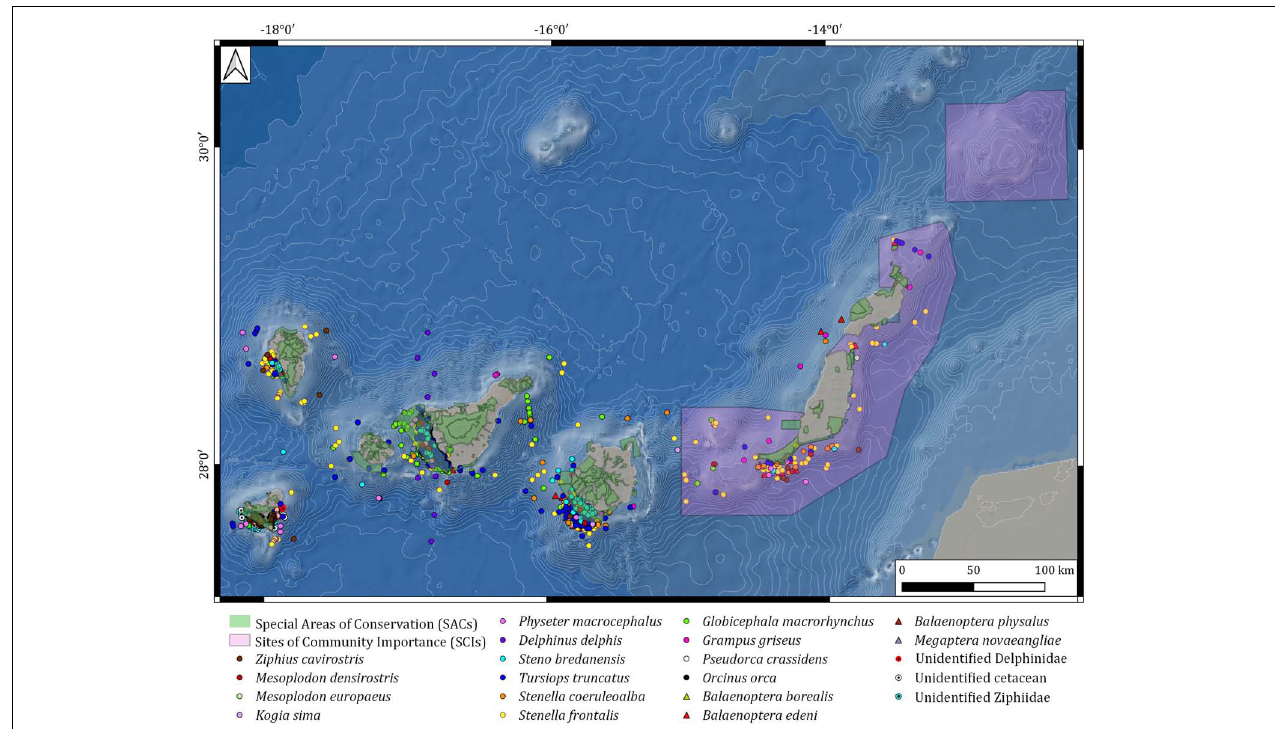
FIGURE 11 | Cetacean spatial distribution around the Canary archipelago (Odontoceti: circles; Mysticeti: triangles), including the Special Areas of Conservation (SACs; green color) and the Sites of Community Importance (SCIs; pink color). Including sightings from El Hierro